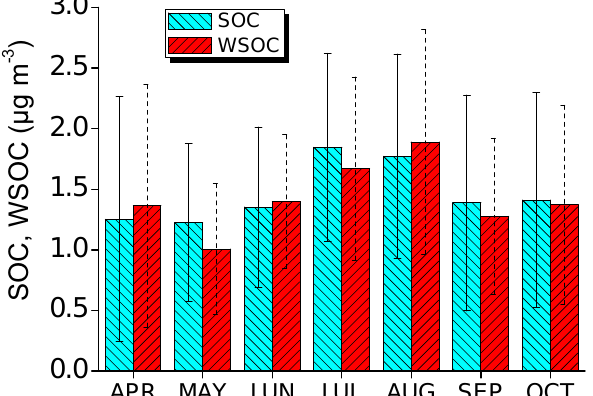
Figure 9. Average monthly variability (from April to October) of WSOC and estimated SOC concentrations, calculated from daily values, for the period May 2008–April